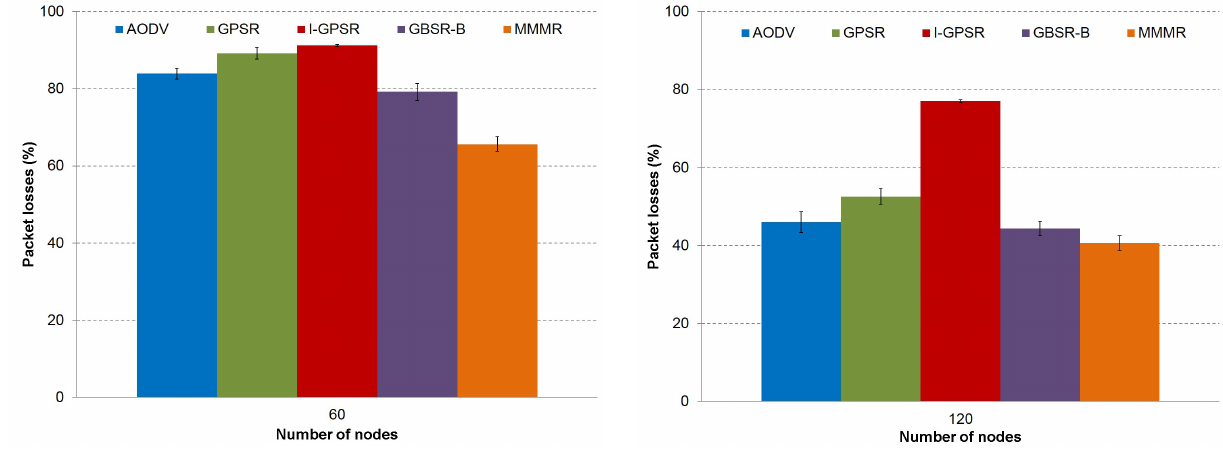
Figure 4. The behavior of the protocols AODV, GPSR, I-GPSR, GBSR-B and MMMR in terms of the percentage of packet losses are presented in ( a ) a low density scenario (60 nodes) and ( b ) a medium density scenario (120 nodes) (CI